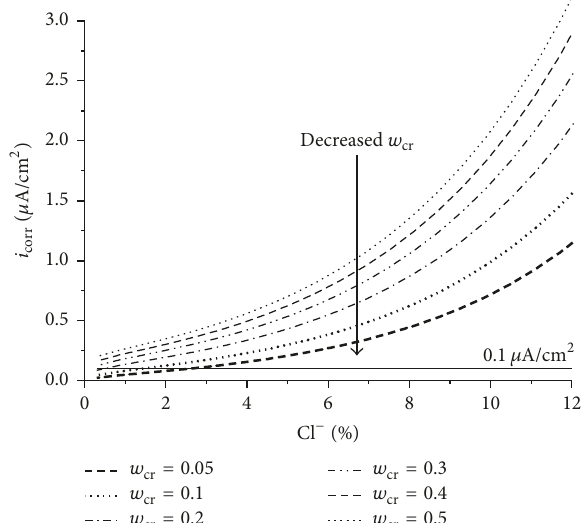
Figure 9: Variation of corrosion rate with the concentration of the Cl − solution.